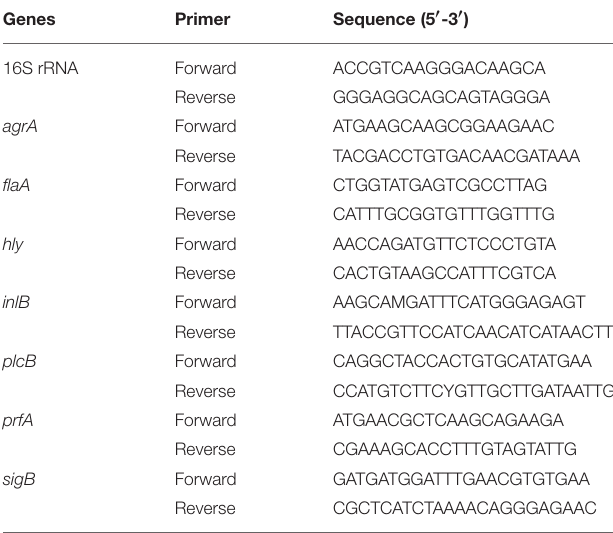
TABLE 2 | Primers used in this